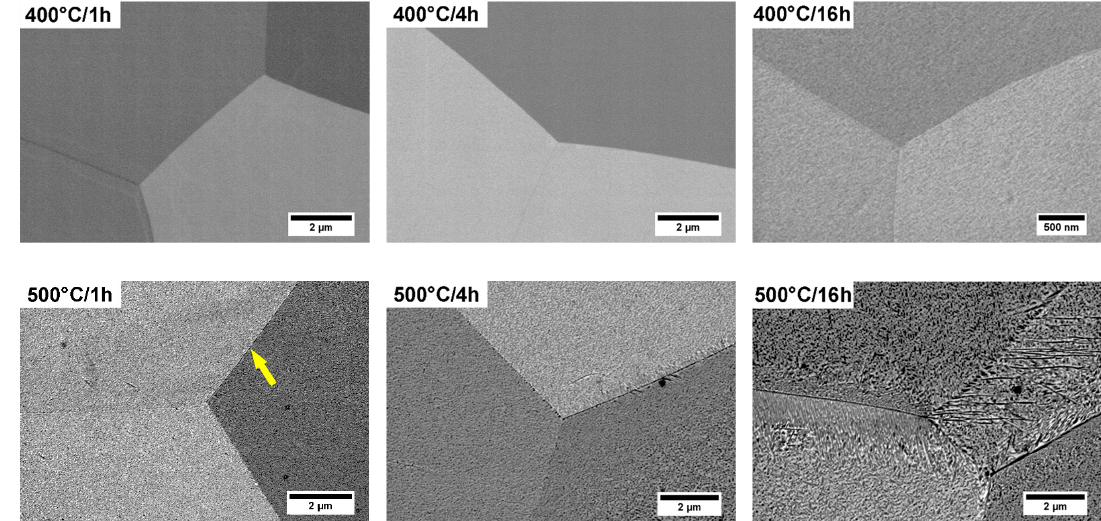
Figure 4. SEM–BSE micrographs of the non-deformed samples after ageing.